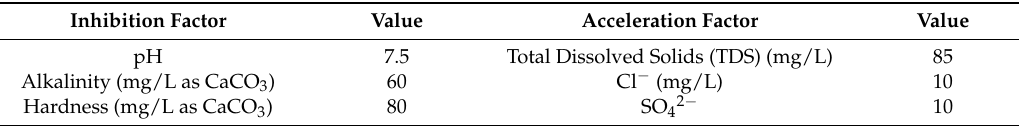
Table 8. Optimizing factors of corrosion control for